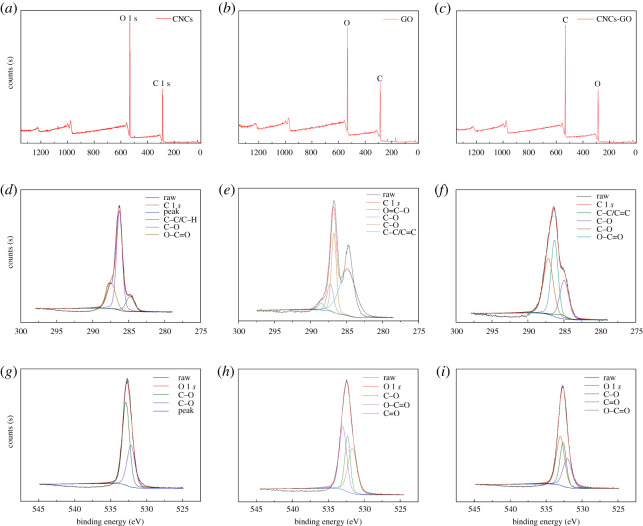
X-ray photoelectron spectroscopy of CNCs, GO and CNCs-GO.